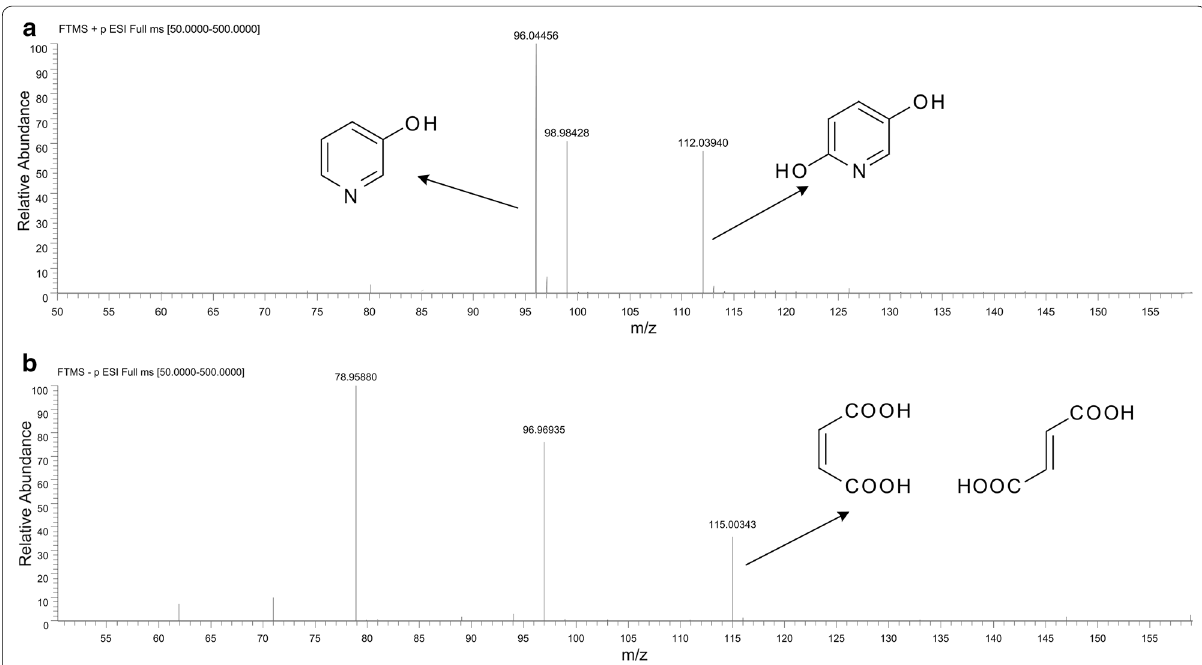
Fig. 6 LC–MS analysis of 3-hydroxypyridine degradation intermediates by strain DW-1. a LC-MS signal of 3-hydroxypyridine and 2,5-dihydroxypyridine. b LC-MS signal of maleic acid and fumaric acid